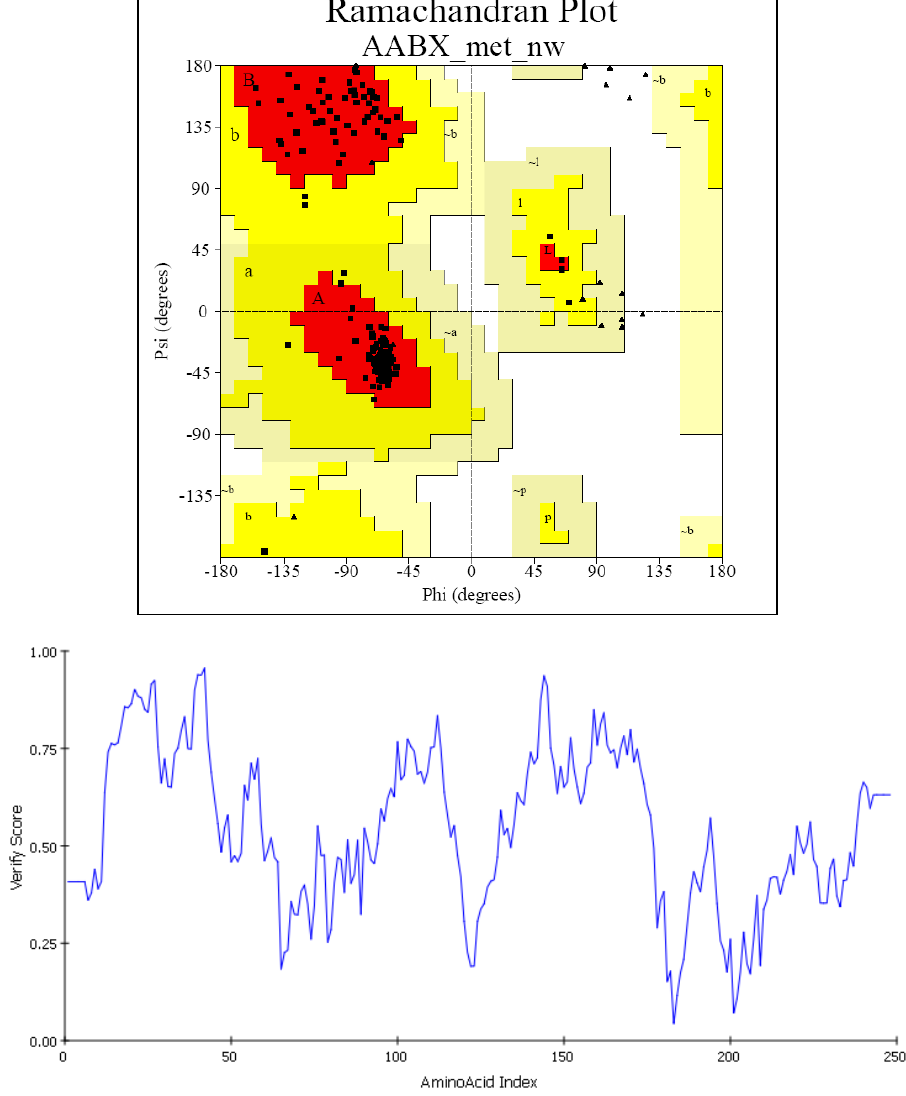
Figure 2. Ramachandran plot (top) of the Psi/Phi distribution of the grape ascorbate peroxidase homology model produced by PROCHECK and the structure evaluation with Profiles-3D (bottom). The favored and most favored regions are yellow and red, respectively. Pale yellow is the generally allowed region and disallowed region is white.